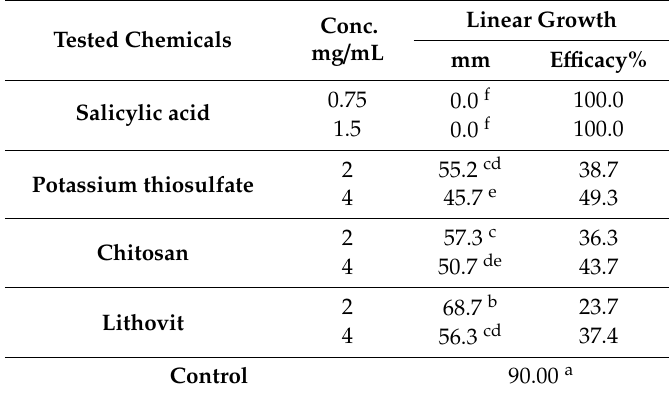
Table 3. E ff ect of tested chemicals on the in vitro growth of Alternaria alternata. Tested Chemicals Salicylic acid